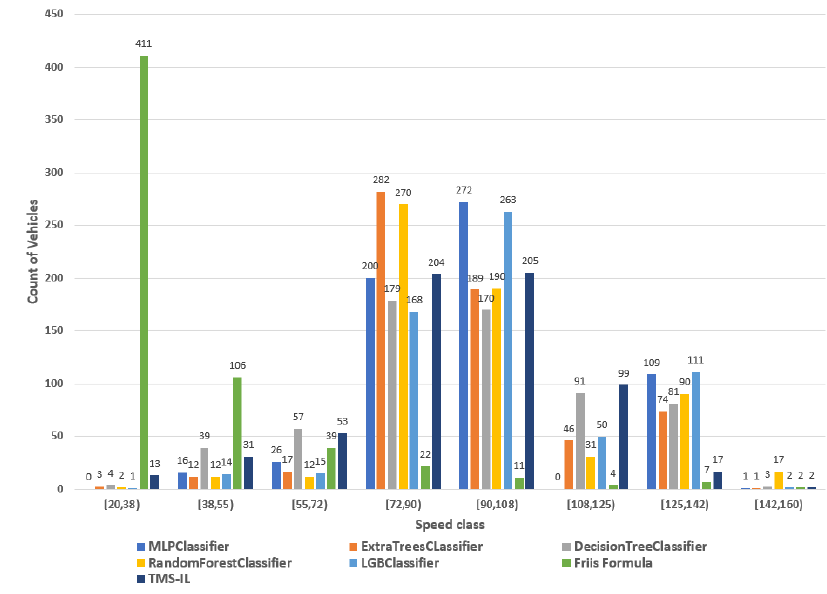
Figure 8. The 8-classes vehicle count per class over TMS-IL count per class.